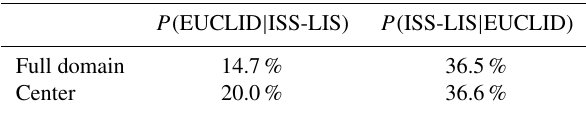
Table 1. Relative detection efficiencies at the level of EUCLID strokes and pulses and ISS-LIS